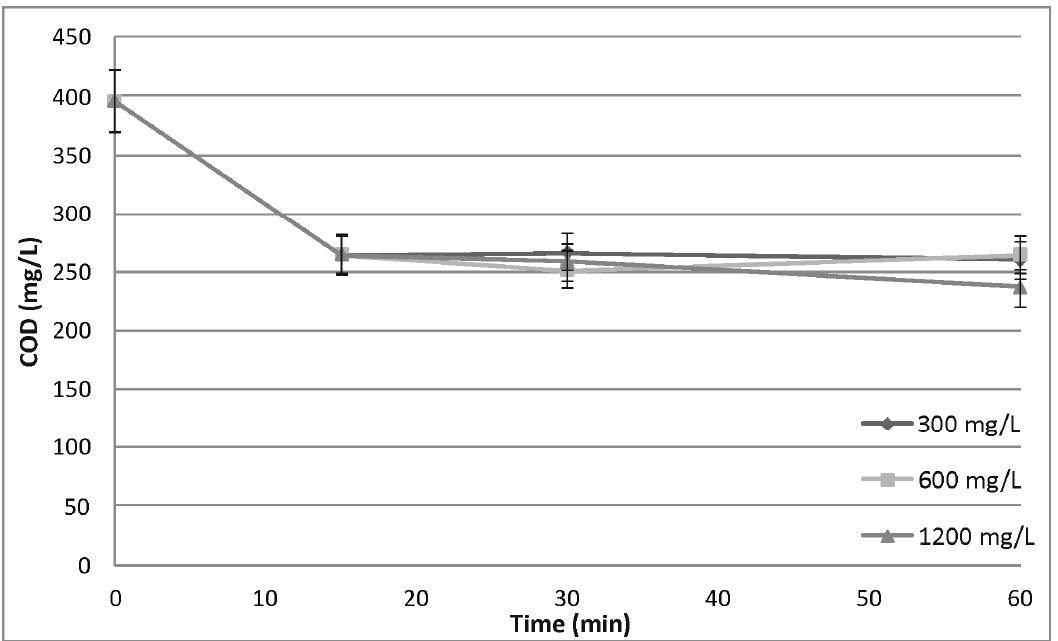
Figure 3. COD removal in Fe 0 /H 2 O 2 process: Fe 0 dose 8 (g/L), raw wastewater.